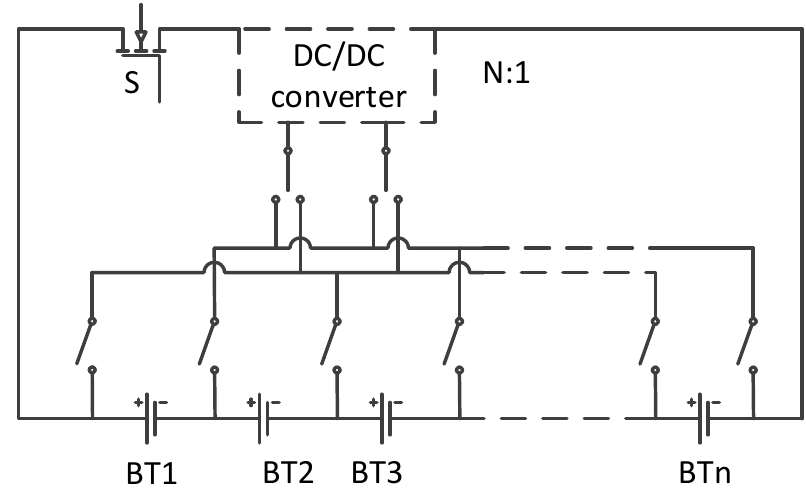
Figure 9. Principle of centralised DC–DC active balance.